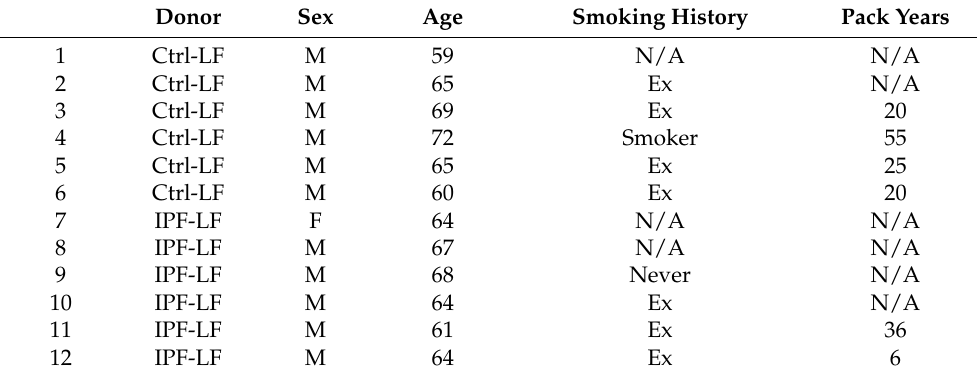
Table 1. Characteristics of fibroblasts donors for ECM